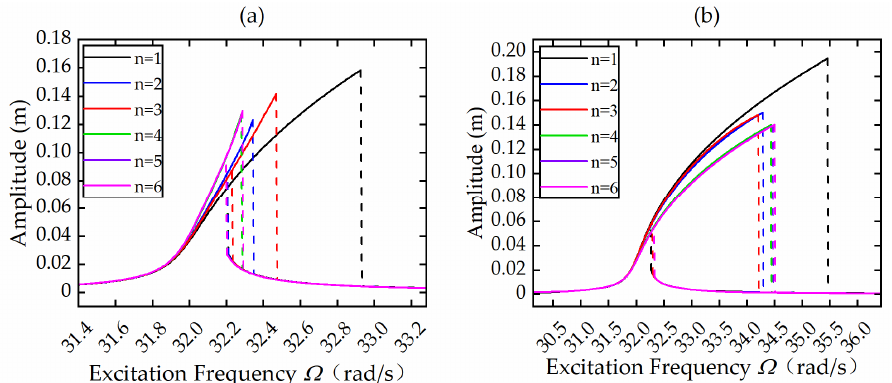
Figure 5. Frequency response curves of the system with the first n modes under different conditions: ( a ) INDM; ( b ) CNDM.